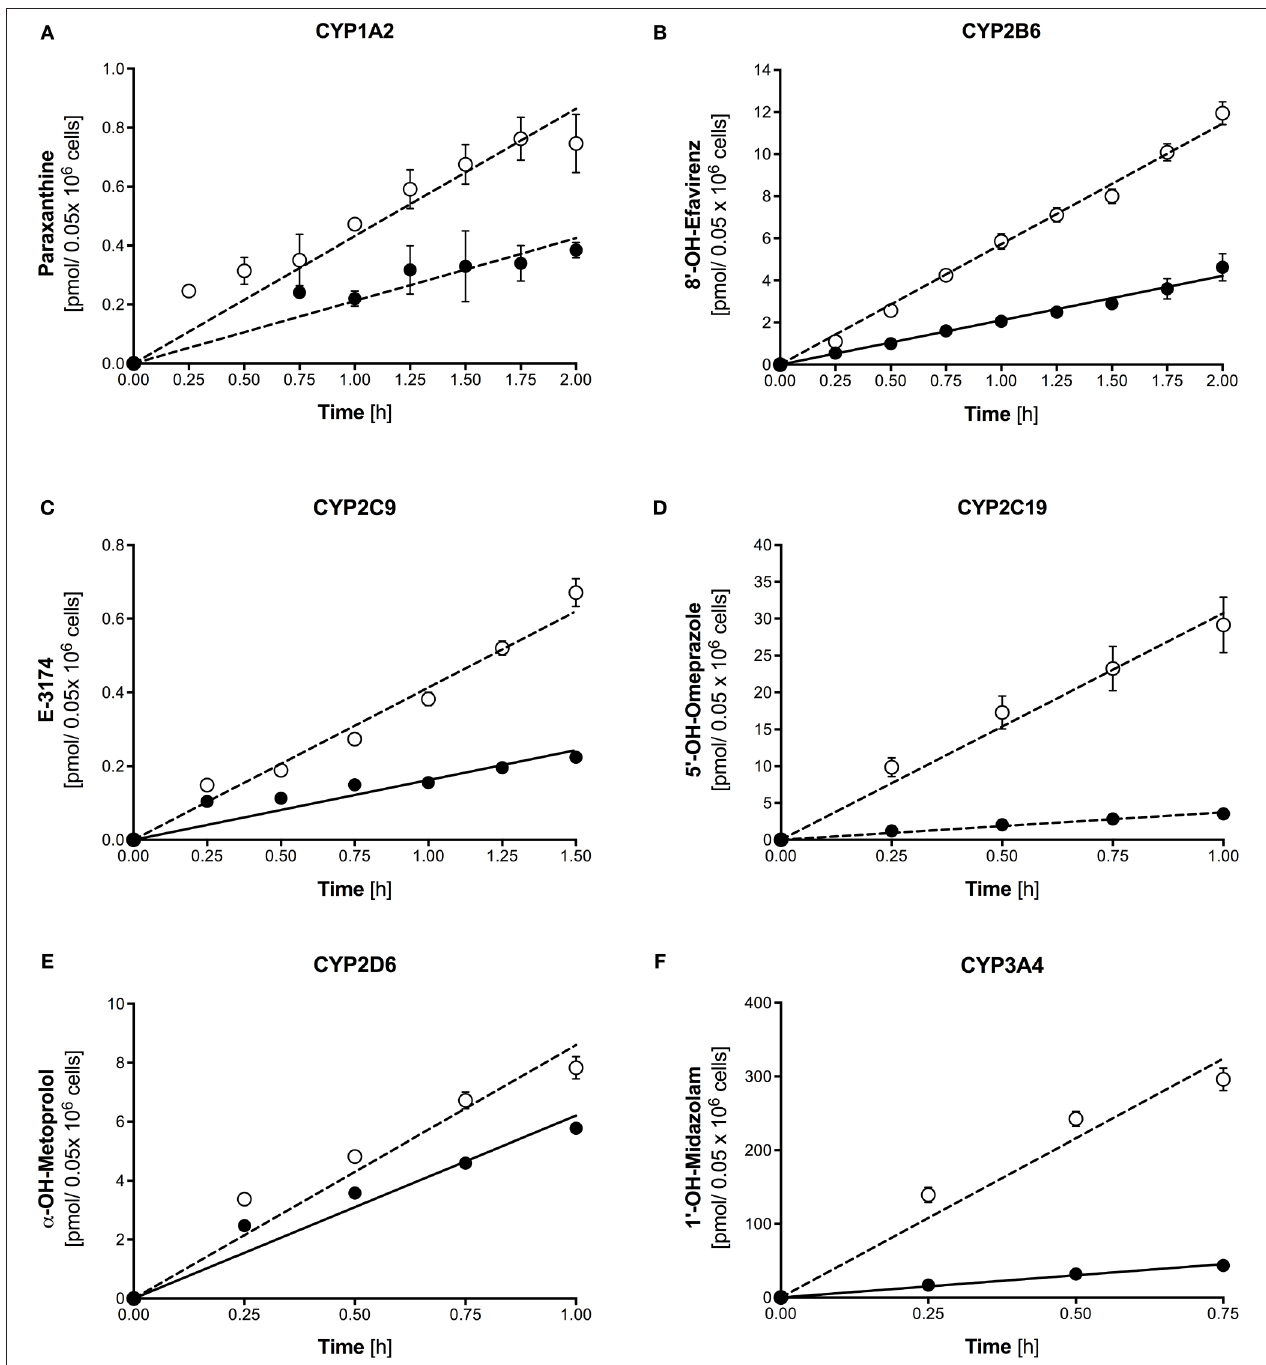
FIGURE 4 | Formation of paraxanthine (A) , 8 ′ -OH-efavirenz (B) , E-3174 (C) , 5-OH-omeprazole (D) , α -OH-metoprolol (E) , and 1 ′ -hydroxymidazolam (F) by 3D-cultured primary human hepatocytes after treatment with 20 µ M rifampicin for 72 h (open symbols) compared to control cultures (closed symbols). Metabolite concentrations were determined by LC-MS/MS. The corresponding formation rates and regression coefficients in control cultures and after treatment with 20 µ M rifampicin are given in Tables 2, 3 . Data are presented as mean ± SEM of at least three independent experiments.